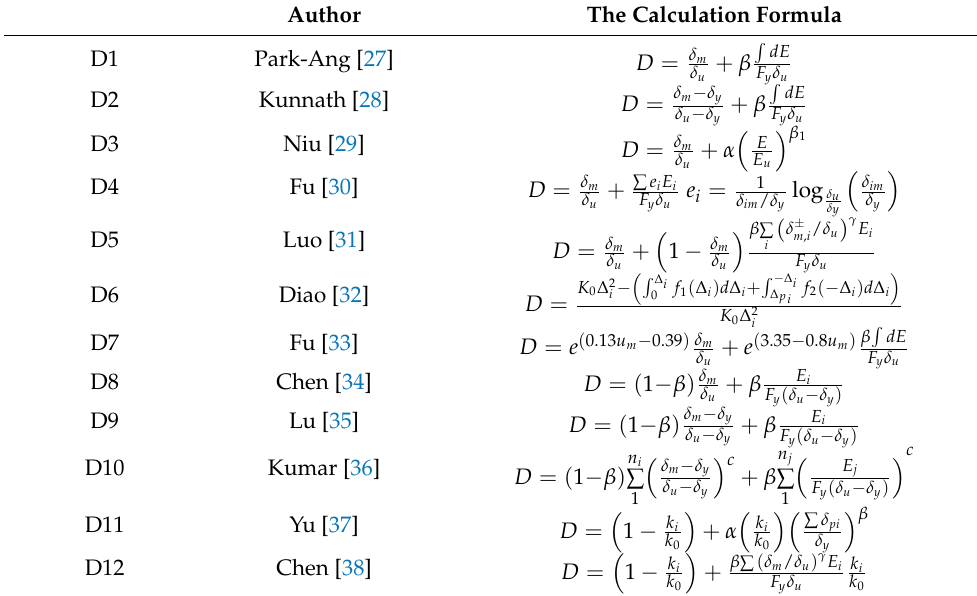
Table 6. Damage model calculation method.